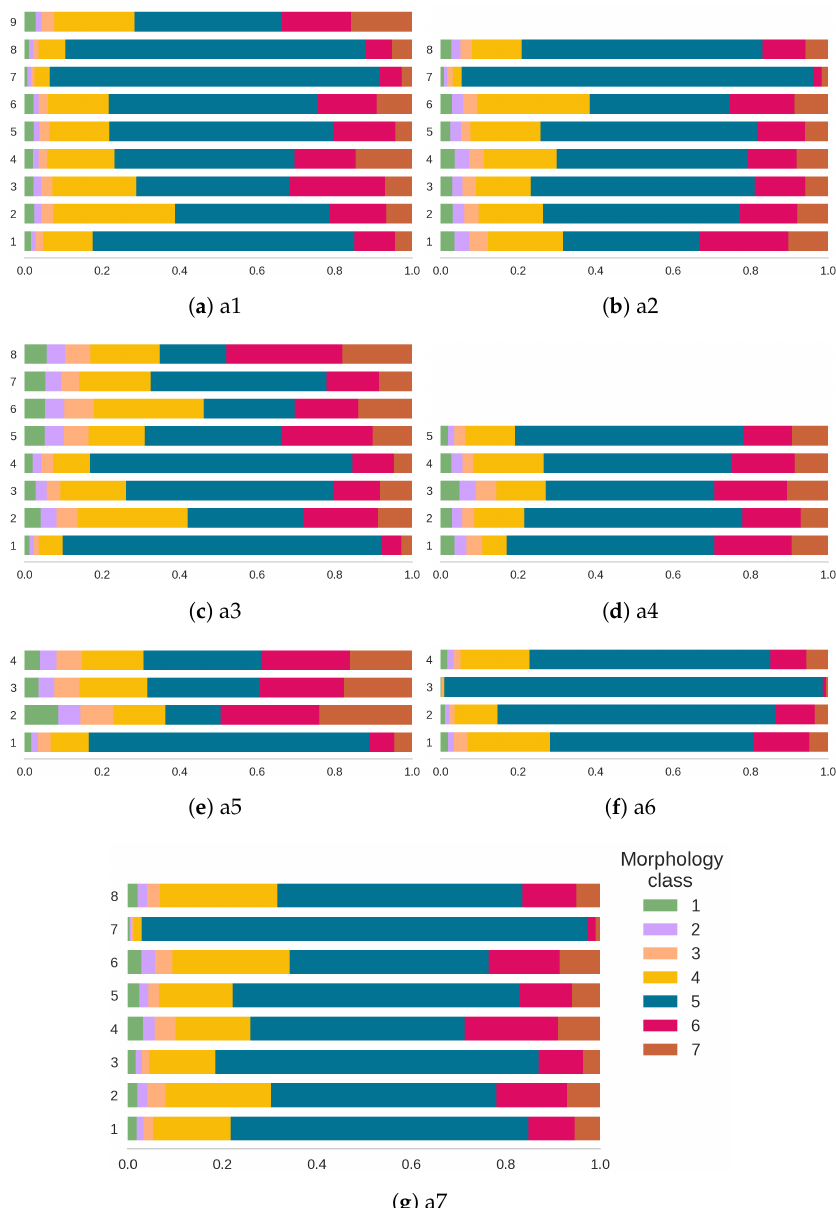
Figure 13. Genomes of defect conglomerates within individual specimens a1 to